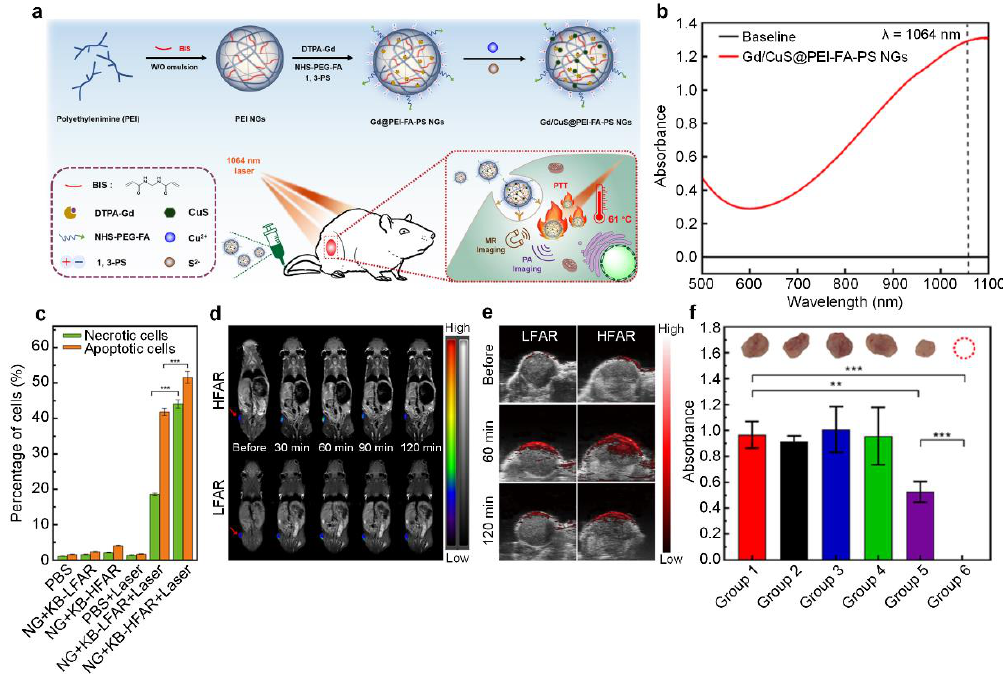
Figure 9. ( a ) Schematic illustration of Gd/CuS@PEI-FA-PS NGs for magnetic resonance imaging (MRI) and photoacoustic (PA) imaging-guided PTT. ( b ) Absorption spectrum of Gd/CuS@PEI-FA-PS NGs. ( c ) Flow cytometry analysis of necrotic and apoptotic KB cells under different treatments. ( d ) In vivo T1-weighted MR ( d ) and PA ( e ) images of high-level FA receptor (FAR) expression (HFAR) and low-level FAR expression (LFAR) tumor-bearing mice in different post-injection time points. ( f ) Tumor weights from mice under different treatments for 24 days. ** p < 0.01; *** p < 0.001. Adapted from [72].